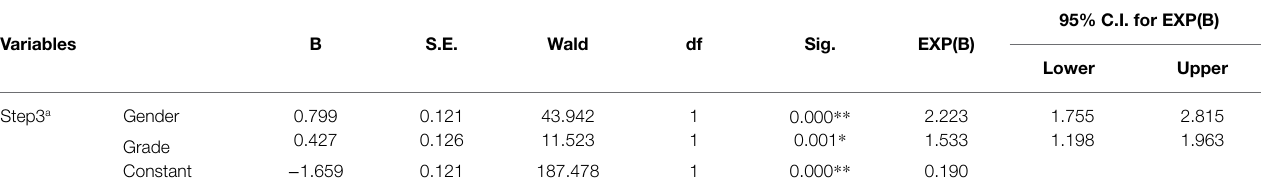
TABLE 11 | Variables in the